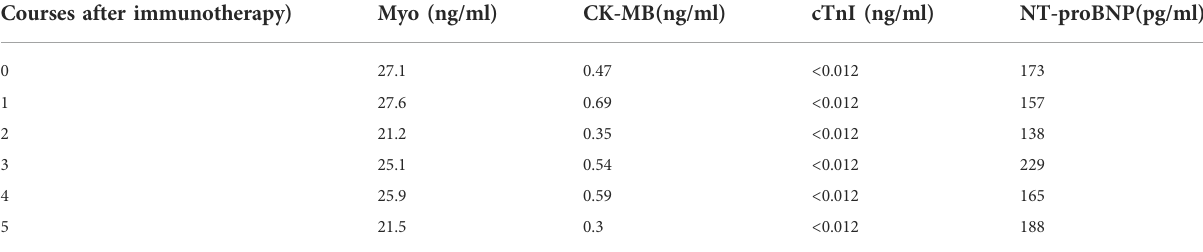
TABLE 1 Levels of myocardial enzymes and NT-proBNP before and after immunotherapy in the patient. Courses after